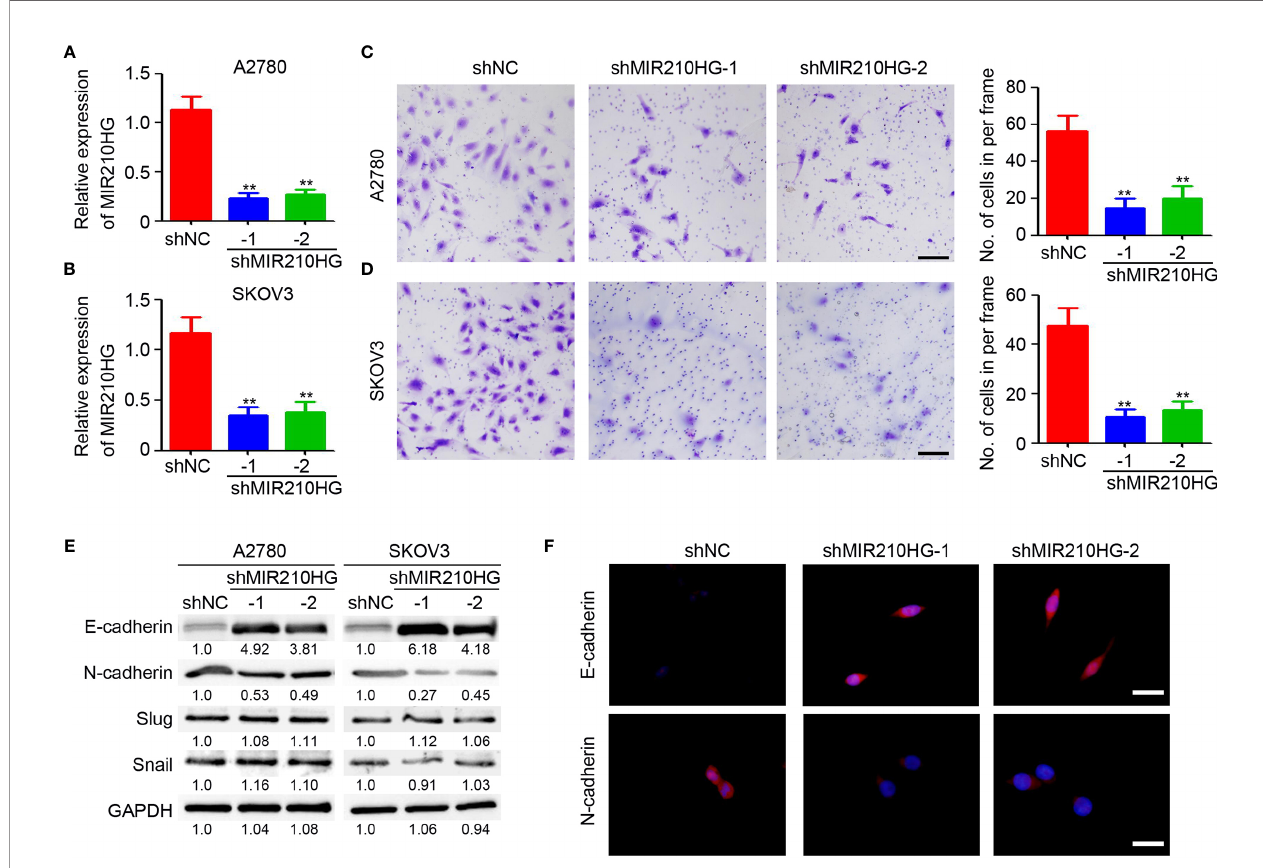
FIGURE 2 | lncRNA-MIR210HG promotes EMT in ovarian cancer. (A, B) qPCR analysis of lncRNA-MIR210HG expression in A2780-shNC, A2780-shMIR210HG, SKOV3-shNC and SKOV3-shMIR210HG cells under hypoxia condition (n = 3, **p < 0.01). (C, D) A2780-shNC, A2780-shMIR210HG, SKOV3-shNC and SKOV3- shMIR210HG cells were used for Matrigel-based migration assay under hypoxia condition. The number of migrated cells in per frame was analyzed (n = 4, **p < 0.01, Scale bar = 100 m m). (E) Detection of E-cadherin and N-cadherin expression in A2780-shNC, A2780-shMIR210HG, SKOV3-shNC and SKOV3-shMIR210HG cells that were cultured under hypoxia condition by western blotting. GAPDH was used as a loading control. (F) Detection of E-cadherin and N-cadherin expression in A2780- shNC and A2780-shMIR210HG cells that were cultured under hypoxia condition by immuno fl uorescent staining (Scale bar = 10 m